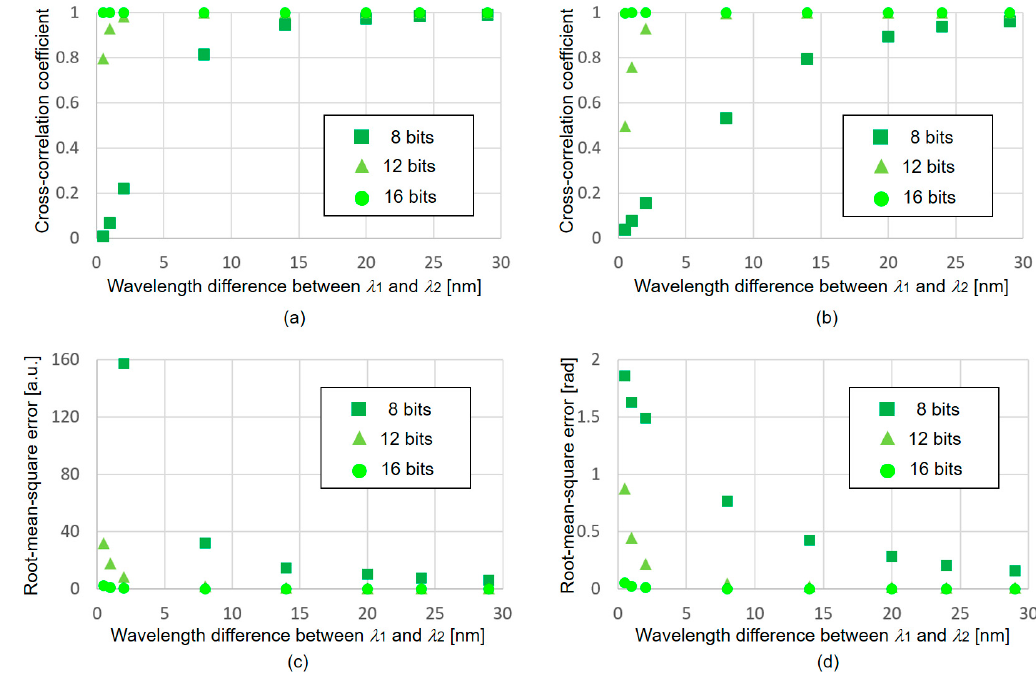
Figure 7. Quantitative evaluations of reconstructed images at λ 2 : CC of reconstructed ( a ) amplitude and ( b ) phase images, and RMSE of reconstructed ( c ) amplitude and ( d ) phase images.